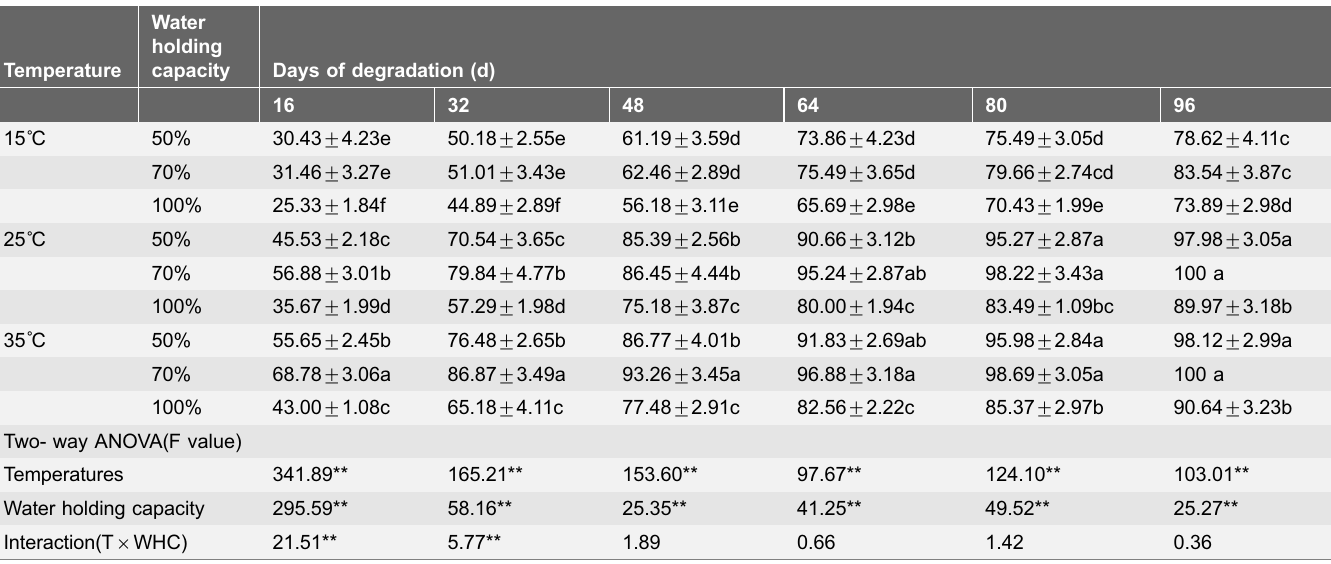
Table 2. The degradation rates (%) of Cry1Ac protein in buds under different soil water content and temperature settings (data reported as the mean of three replicates ¡ standard deviation). Water Temperature